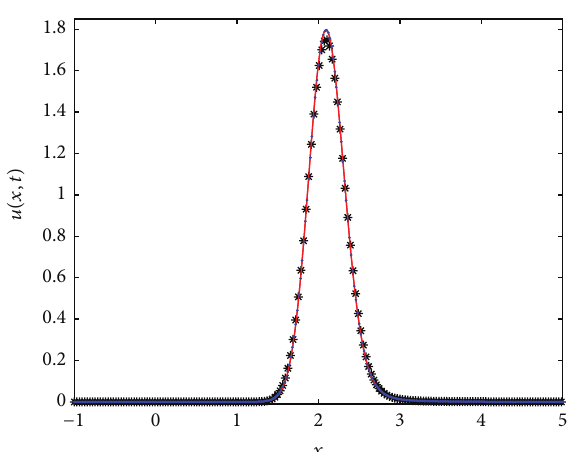
Figure 3: Numerical solutions and exact solution at 𝑡 = 1.5 with 𝑑 = 0.02 . The solid line corresponds to the exact solution and the dotted line corresponds to numerical solution of the CFDM with 𝛼 = 1.9 , Δ𝑥 = 1/100 , and Δ𝑡 = 1/30 . The stared line corresponds to numerical solution of the implicit SFDM with Δ𝑥 = 1/1000 and Δ𝑡 = 1/5000